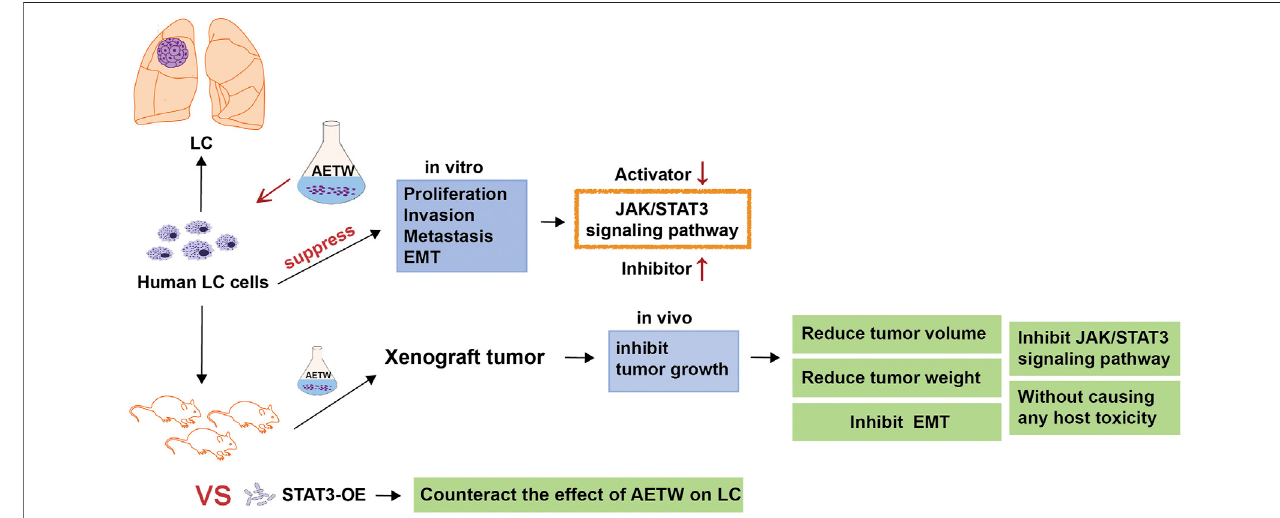
FIGURE 1 | Experimental fl owchart.